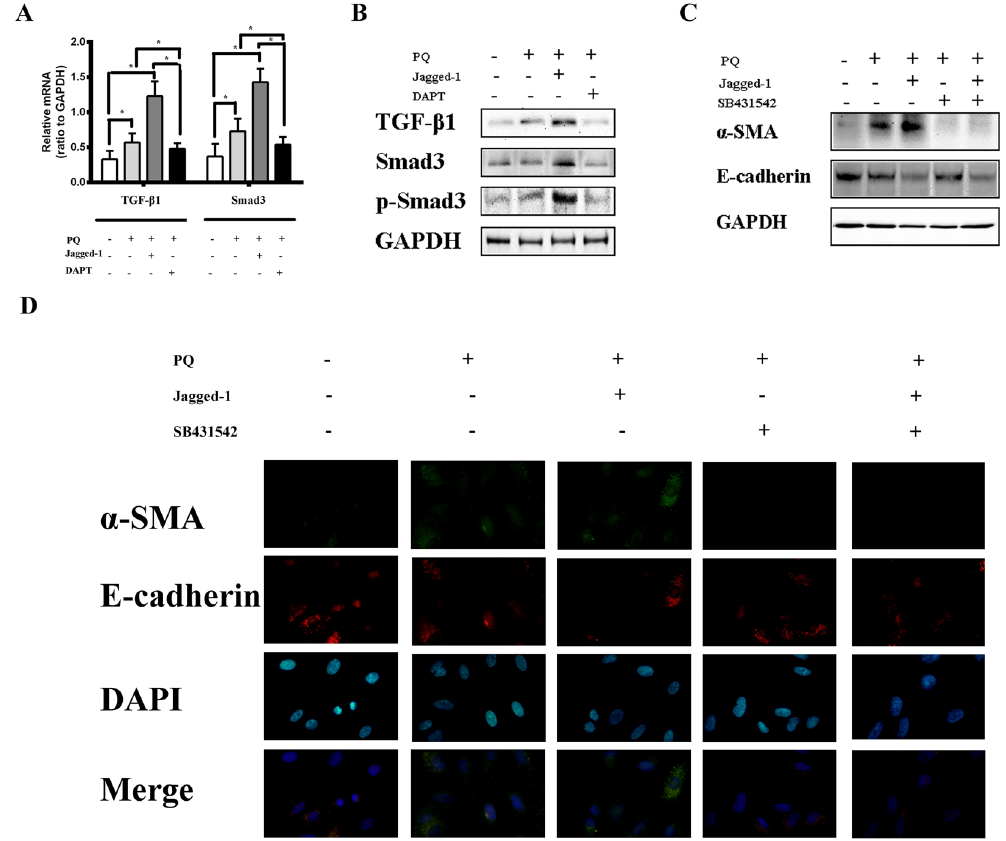
Figure 4. Notch1 pathway upregulates TGF- β 1/Smad3 pathway. ( A ) We cultured A549 cells for 6 days, with PQ (300 μ mol/L), PQ + Jagged-1(500 ng/mL), or PQ + DAPT (10 μ mol/L). The mRNA level of TGF- β 1 and Smad3 was increased after induction by Jagged-1, while DAPT could inhibit the mRNA of TGF- β 1 and Smad3 byqRT- PCR. ( B ) A549 cells were cultured with PQ or PQ + Jagged-1, incubated in the presence or absence of SB431542 (a specific inhibitor of TGF- β receptor type I/ALK5 kinase that phosphorylates Smad2/3, 10 μ mol/L) for 6 days. Jagged-1 significantly induced α -SMA, and this induction was completely inhibited by SB431542 in A549 cells by western blot analysis. ( C ) Cell membrane distribution of α -SMAand E-cadherin protein in A549 cells. Jagged-1 significantly induced expression of α -SMA protein, and this induction was inhibited by SB431542 in A549 cells. α -SMA was stained green, E-cadherin was stained red and DAPI stained nuclei blue. * p <